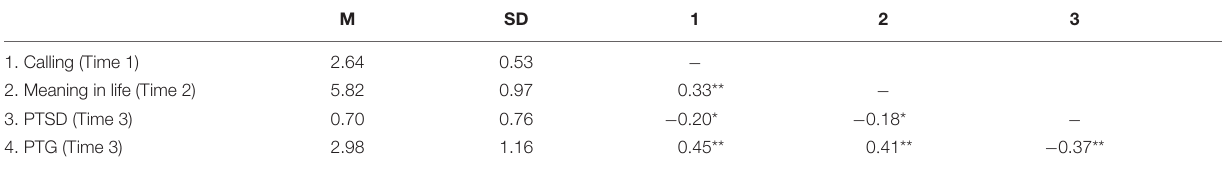
TABLE 1 | Descriptive statistics and correlation analysis.